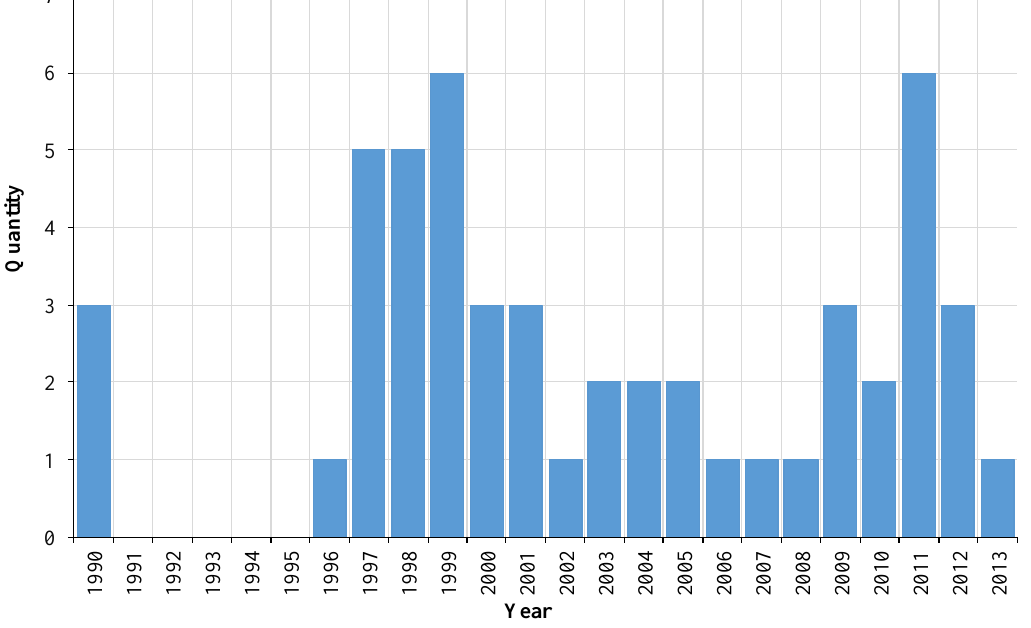
Figure 1. Construction dynamics of the small-scale hydropower plants (SHPPs) from 1990–2013.